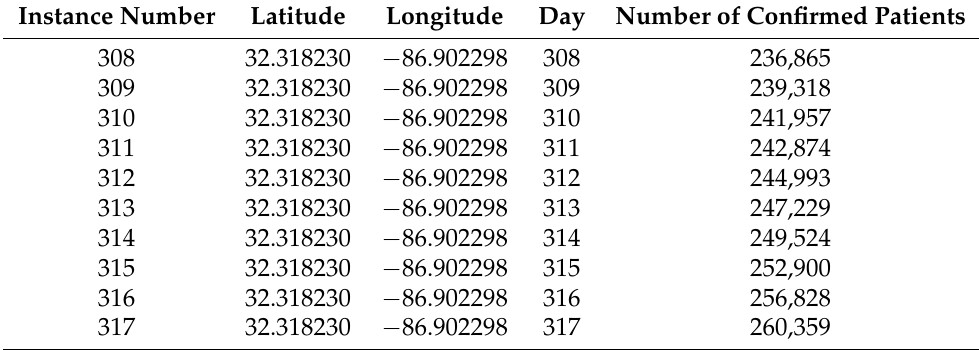
Table 1. The last ten instances of the confirmed number of patients dataset for state of